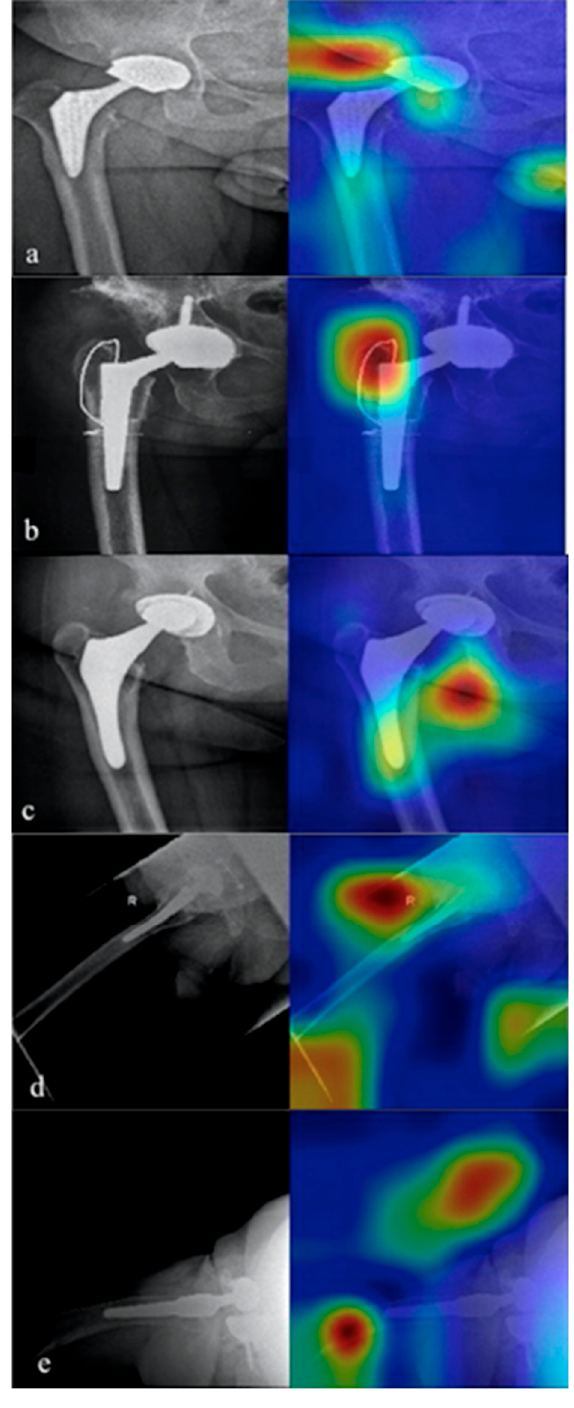
Figure 7. The five misclassified images. In ( a ) the algorithm did not detect a stem osteolysis. In ( b ) the cerclage wiring around the prothesis was wrongly classified as pathological by the algorithm. In ( c ) the algorithm did not detect the polyethylene insert wearing. In ( d ) the stem loosening was not detected. In ( e ) a severe cup loosening with luxation was not